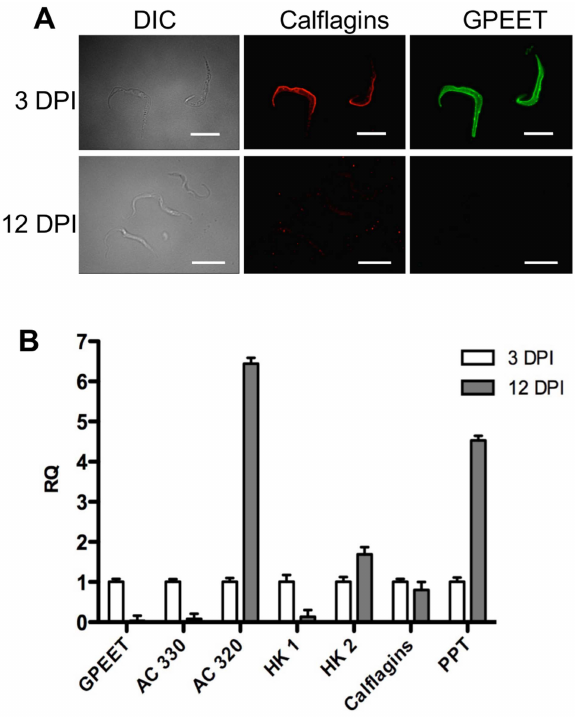
Figure 7. Differential expression of early and late procyclic form markers in tsetse flies. A. GPEET and calflagin are co-expressed by early procyclic forms 3 days post infection (DPI), but neither is detectable in late procyclic forms 12 DPI. Trypanosomes were isolated from tsetse fly midguts, fixed with formaldehyde and glutaraldehyde and permeabilised with Triton- 6 100. Immunofluorescence was per- formed with anti-GPEET and anti-calflagin antisera. Scale bar: 10 m m. B. Quantitative RT-PCR was performed with RNA isolated from infected tsetse flies 3 and 12 days post infection. Gene designations are the same as for Figure 6. RQ: relative quantification. a -tubulin was used to normalise mRNA levels. Error bars are D Ct standard errors.